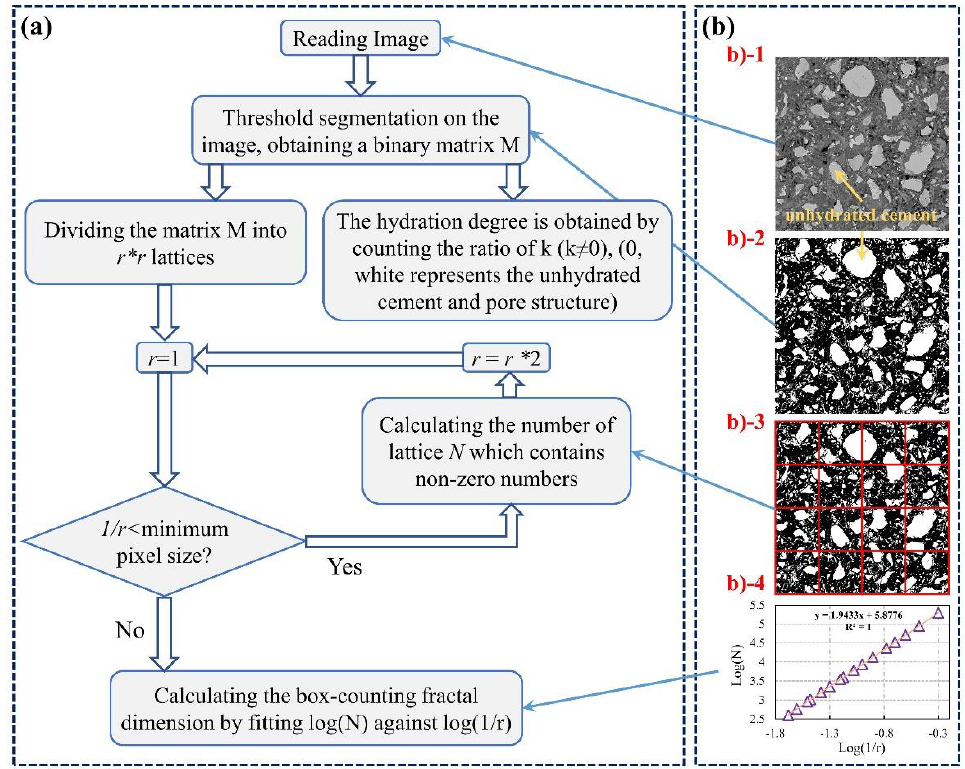
Figure 2. Calculation algorithm of box-counting dimension based on BSE image ( a ) and BSE image processing process ( b ).